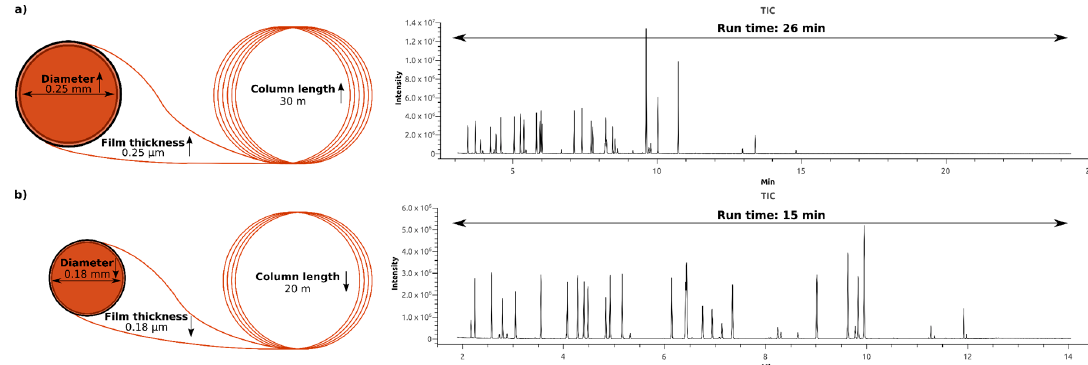
Figure 2. Optimization of the gas chromatography method—( a ) GC column of 30 m in length, inner diameter of 0.25 mm and film thickness of 0.25 µm results in a run time of 26 min; ( b ) GC column of 20 m in length, inner diameter of 0.18 mm, and film thickness of 0.18 µm results in a run time of 15 min.